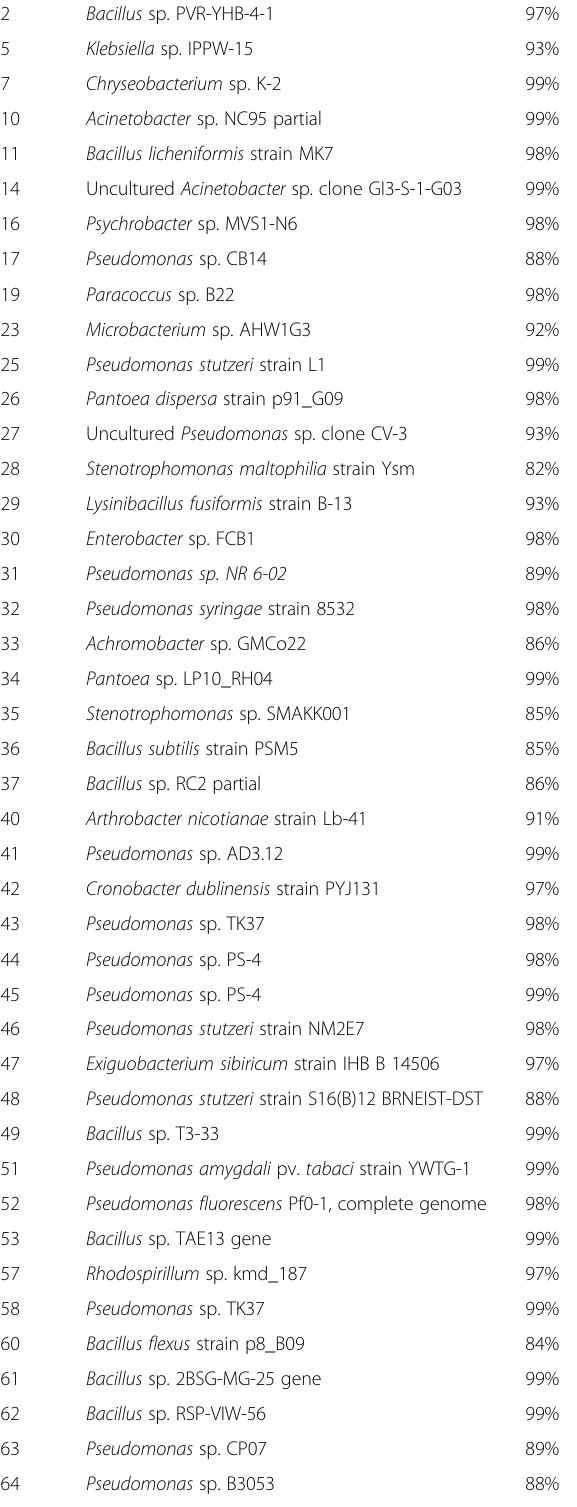
Table 3 Identification of bacterial isolates (QUSA) and their high similarity using 16S rDNA gene sequencing